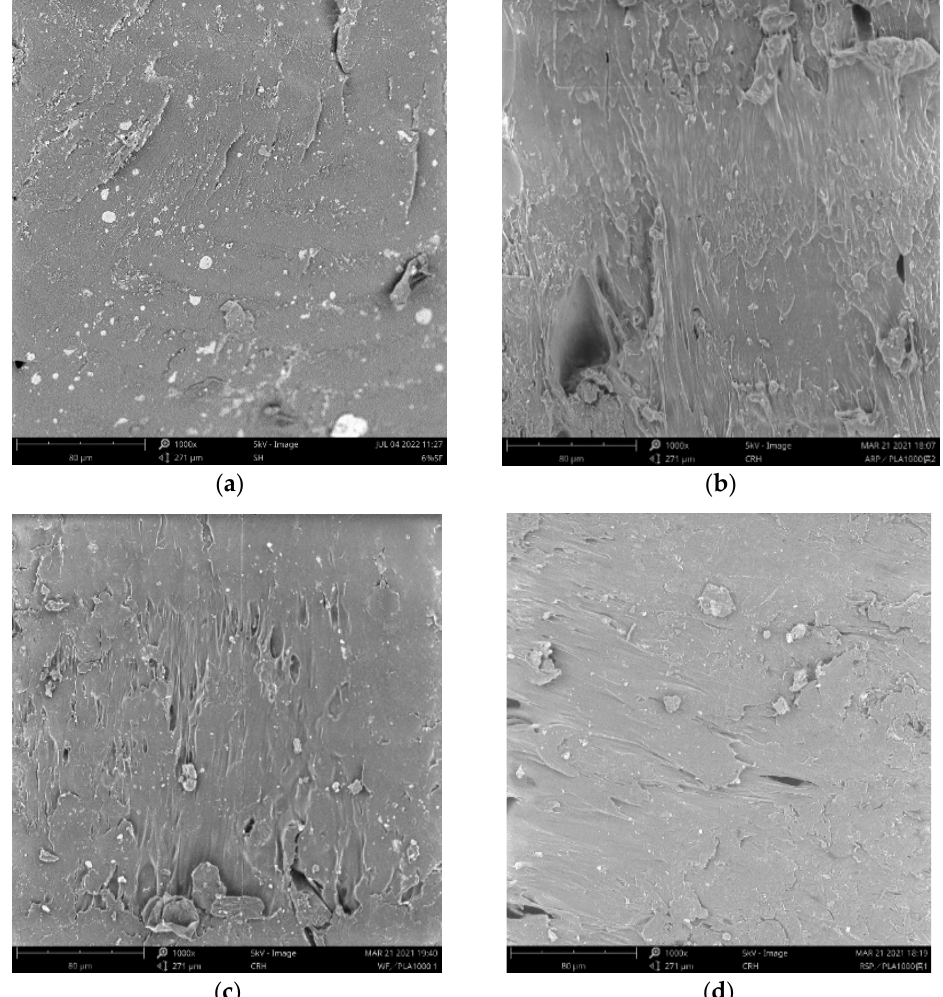
Figure 4. Micro morphologies of PLA and different plant fiber/PLA biocomposite specimens: ( a ) PLA; ( b ) ARP/PLA; ( c ) WF/PLA; and ( d ) RSP/PLA.